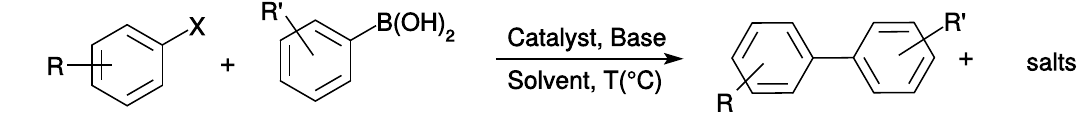
Figure 3. Schematic representation of the Suzuki coupling - R’= H (otherwise